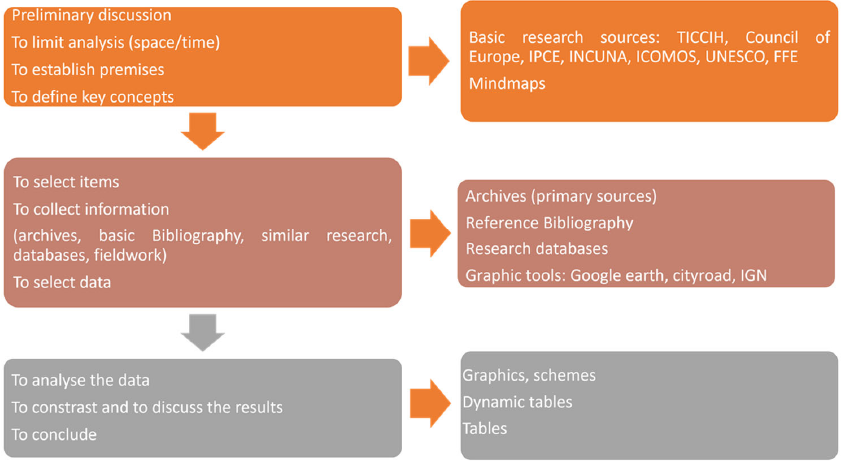
Figure 1. Sequence of research methodology. Own elaboration.